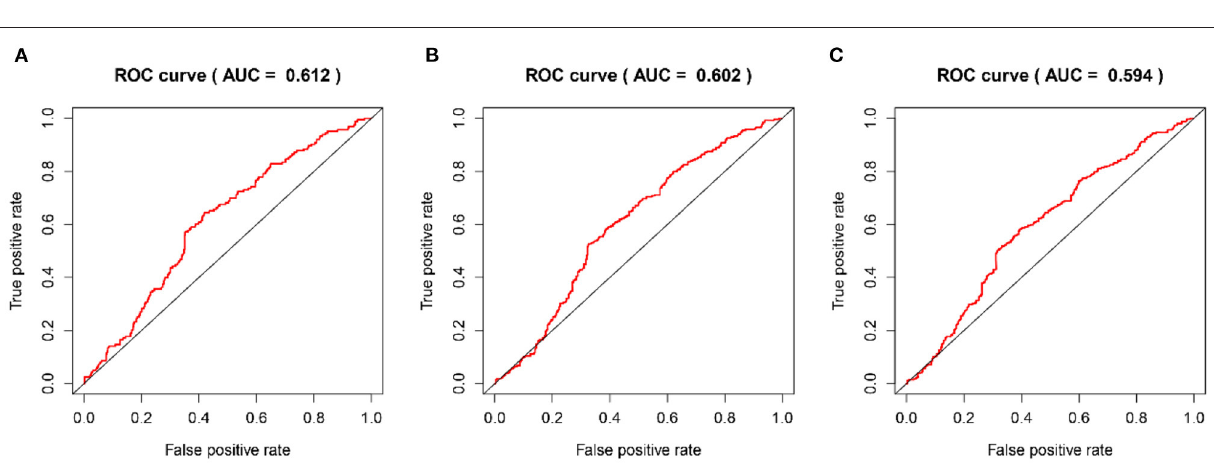
FIGURE 5 | The time-dependent ROC curves in the CGGA validation cohort. (A–C) ROC curves to validate the predictive accuracy of the model for OS at 1-, 2-, and 3-years in the CGGA validation